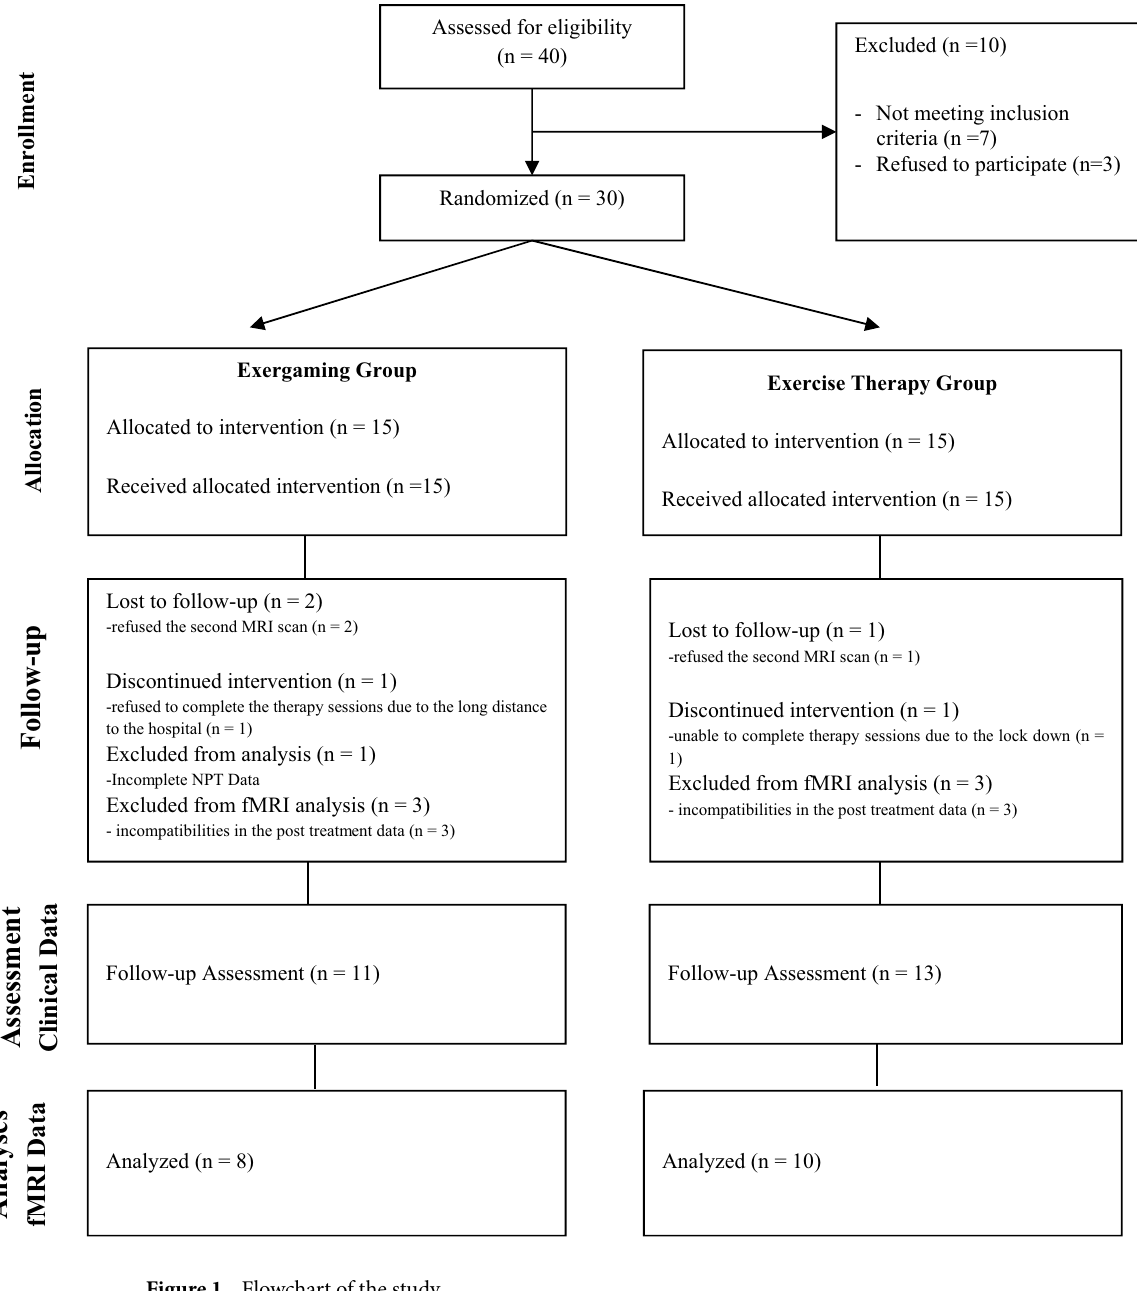
Figure 1. Flowchart of the